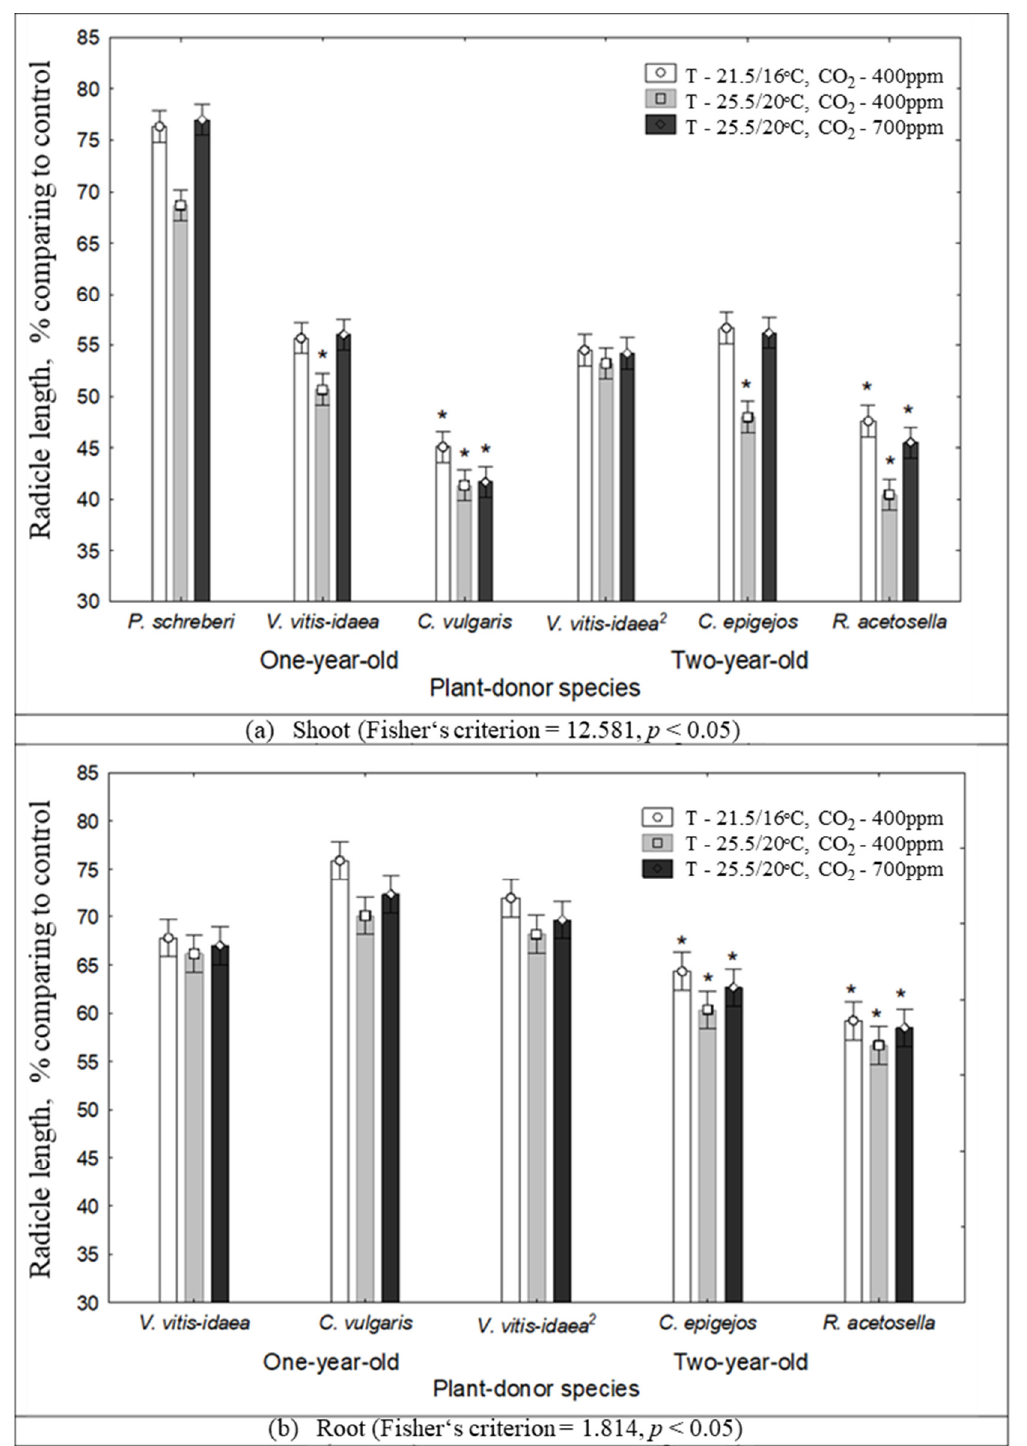
Figure 4. The impact of climate conditions on Scots pine radicle length under the effect of plant-donor shoot ( a ) and root ( b ) extracts (mean ± SD, *— p < 0.05 Kruskal–Wallis test). Control conditions (21.5/16 ◦ C and 400 ppm CO 2 concentration), temperature increases of 4 ◦ C compared to the current conditions (25.5/20 ◦ C and 400 ppm CO 2 concentration), increasing temperature with higher CO 2 concentration conditions (25.5/20 ◦ C and 700 ppm CO 2 ). ( 2 )—dominant species of 2-year-old clear-cuts.